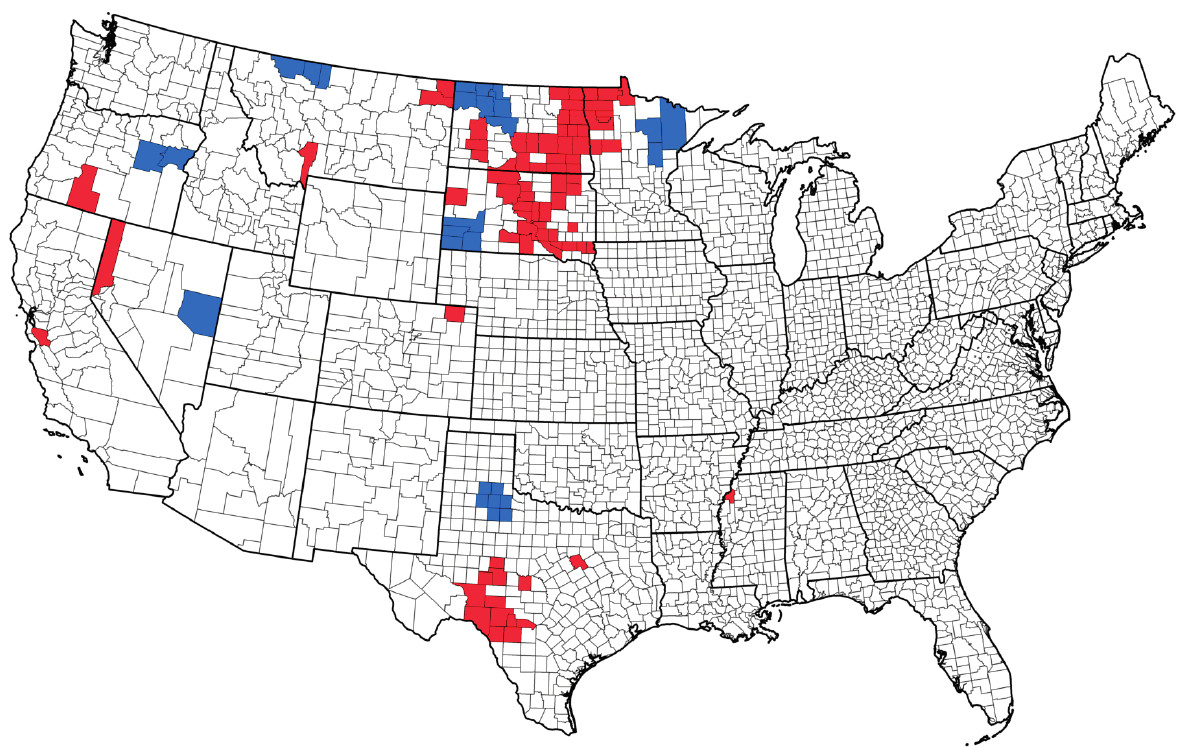
Figure 1. Counties (red) in the contiguous United States reporting cases and/or outbreaks of agricultural/wildlife anthrax since 2000. Counties with no reported cases (blue) where sample sites were utilized for geochemical statistical analyses versus those sample sites in counties in the same state that reported cases and/or